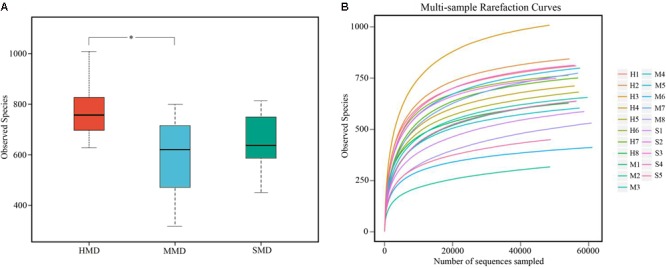
Boxplot and rarefaction curves of operational taxonomic units (OTUs). (A) Boxplot of OTUs of observed species. The x-axis shows the observed species (OTUs) and the y-axis shows different groups. The OTU similarity threshold of 97% was considered. Boxes represent the interquartile range (IQR) between the first and third quartiles (25th and 75th percentiles, respectively), and the horizontal line inside the box defines the median. Whiskers represent the lowest and highest values within 1.5 times the IQR from the first and third quartiles, respectively. ∗P < 0.05 (Student’s t-test). (B) The rarefaction curves of OTUs. The x-axis shows the number of valid sequences per sample and the y-axis shows the observed species (OTUs). Each curve in the graph represents a different sample and is shown in a different color. As the sequencing depth increased, the number of OTUs also increased. Eventually the curves began to plateau, indicating that as the number of extracted sequences increased, the number of OTUs detected was decreased.